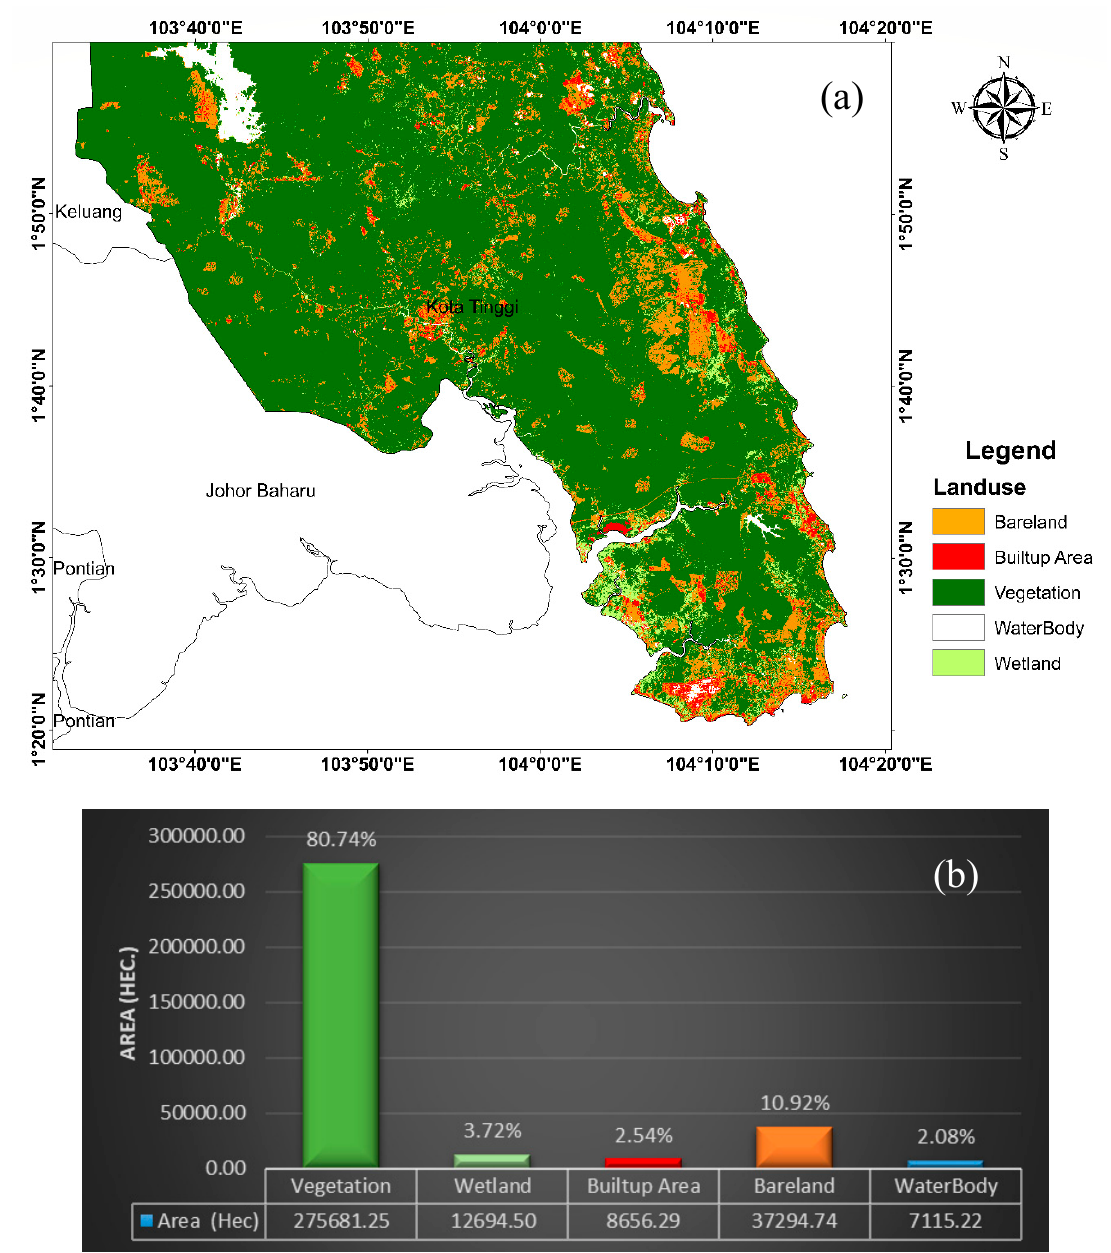
Figure 3. ( a ) 2014 Land Use Land Cover (LULC) map of the study area. ( b ) Area quantification of the 2014 LULC.